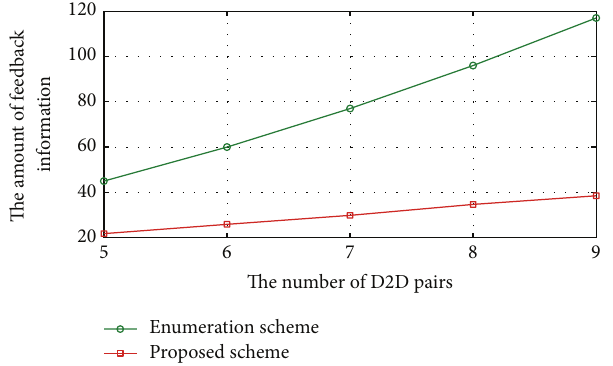
Figure 5: The average feedback amount with the number of D2D